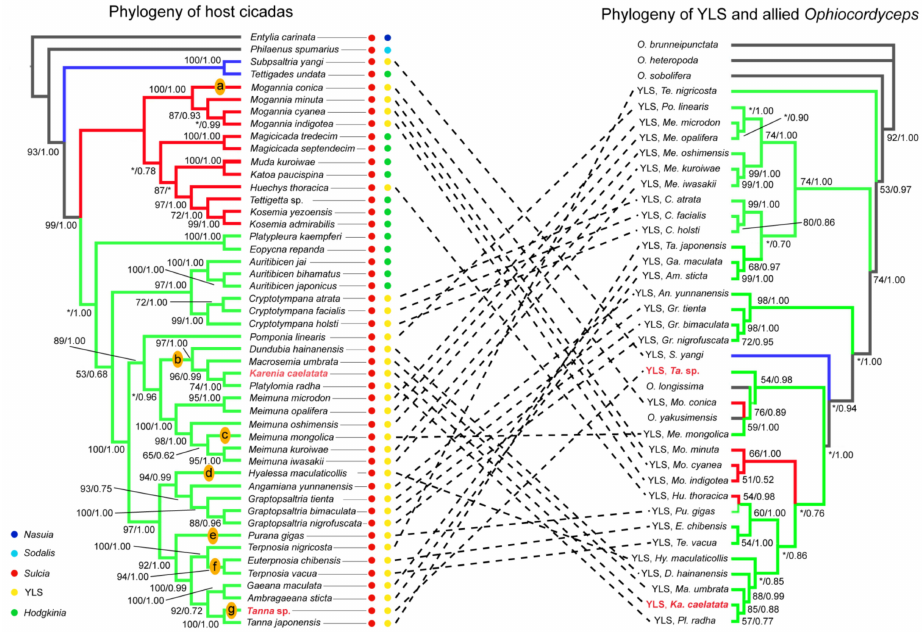
Figure 8. Compared analysis of the phylogeny of host cicadas and YLS. The phylogenetic relation- ship of host cicadas was reconstructed based on joint mitochondrial genes ( COI + COII + Cytb